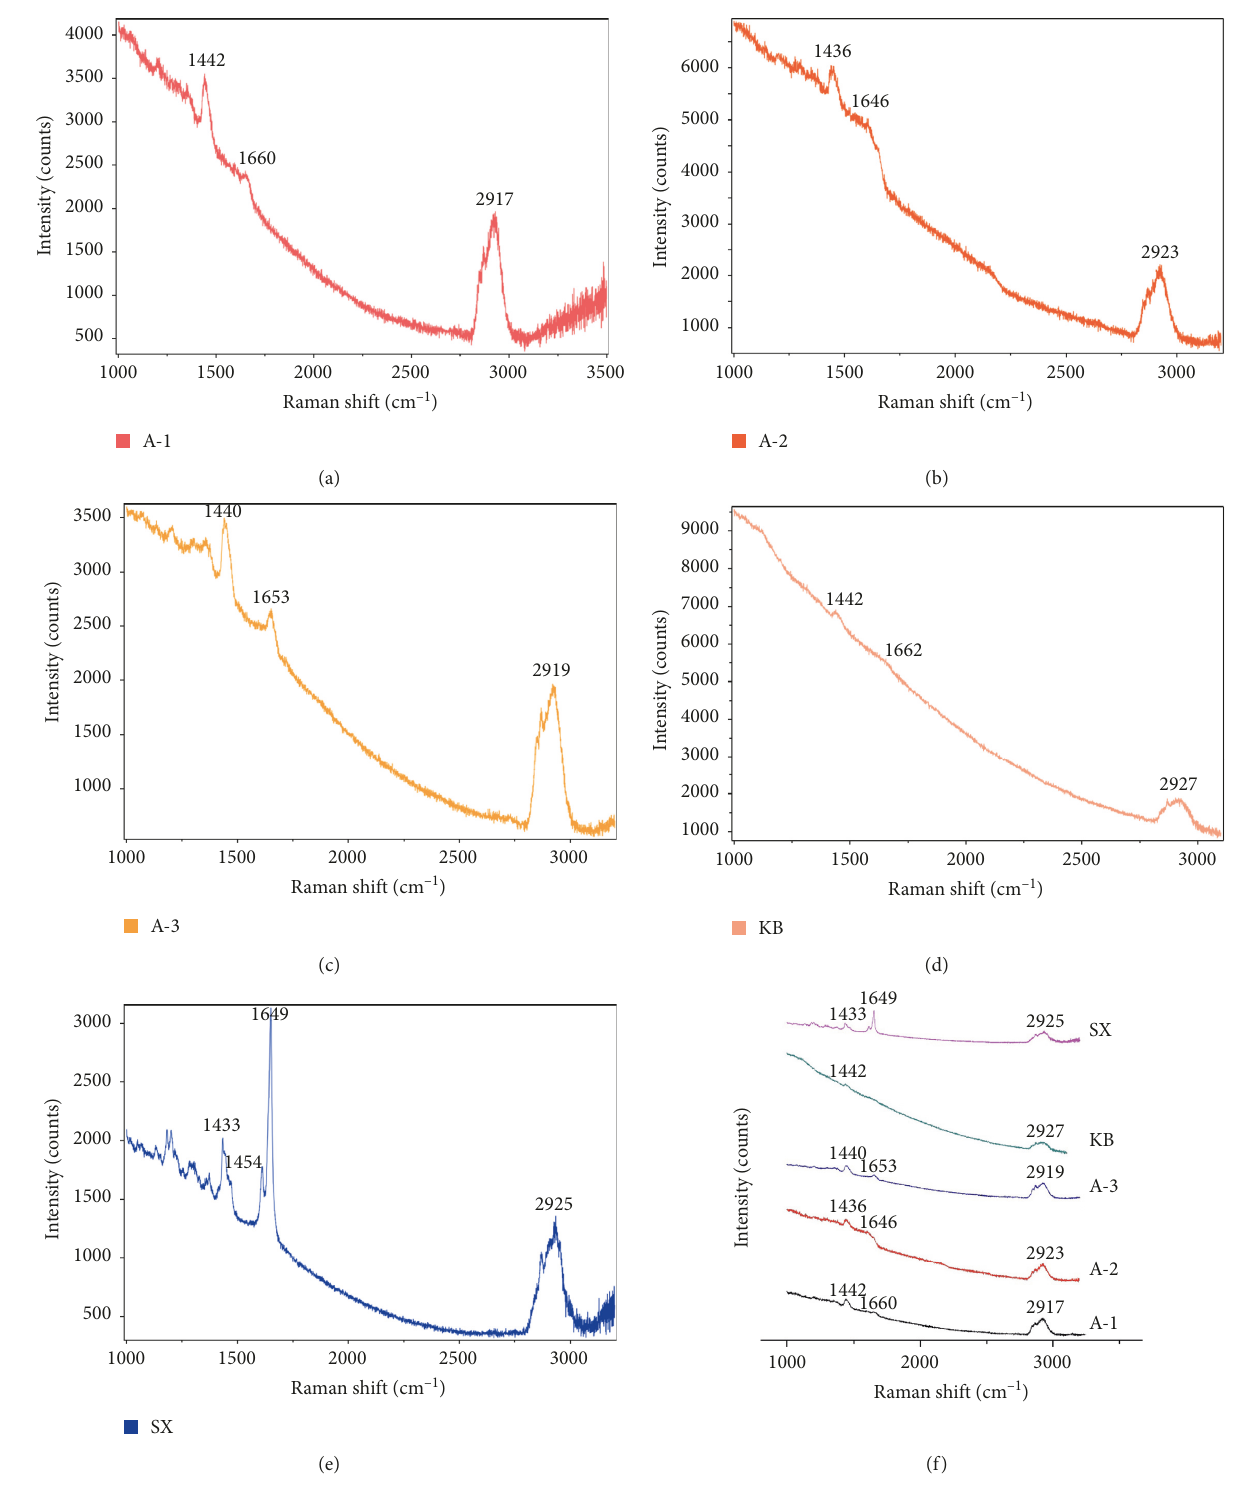
Figure 3: Raman spectra of amber, copal, and rosin samples. Burmese amber samples: (a) A-1, (b) A-2, and (c) A-3. (d) Copal sample (KB). (e) Rosin sample (SX). (f) All